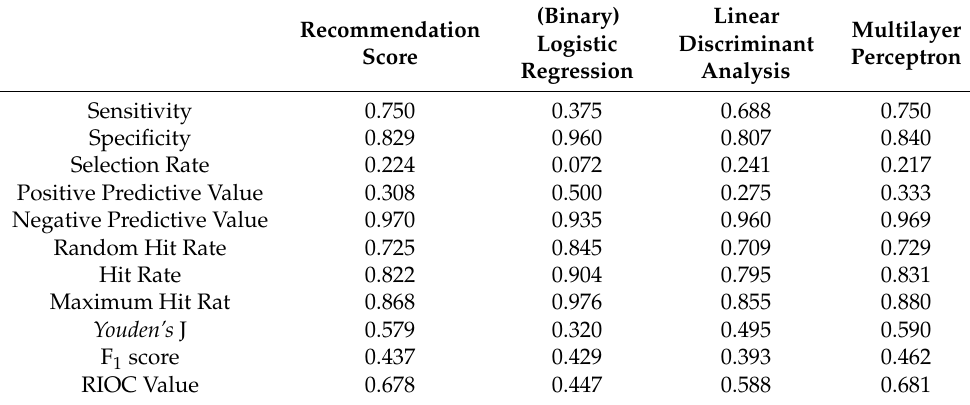
Table 7. Comparison of the prognostic validity of the four analyses.